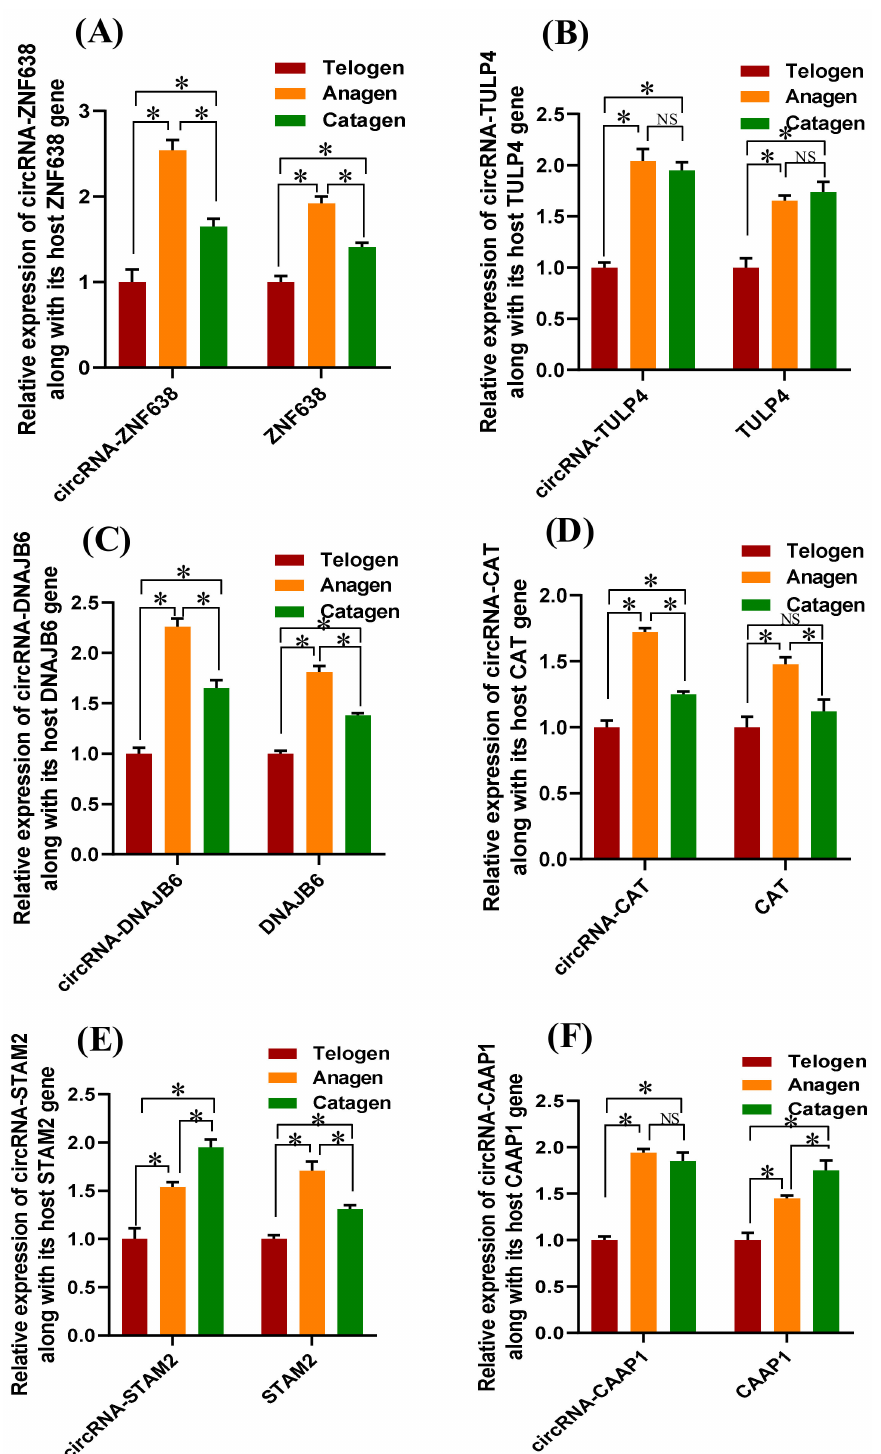
Figure 7. Expression analyses of the six anagen up-regulated m 6 A-circRNAs along with their host genes in SHFs of cashmere goats at telogen, anagen, and catagen stages. ( A ): circRNA-ZNF638 and its host gene ZNF638, ( B ): circRNA-TULP4 and its host gene TULP4, ( C ): circRNA-DNAJB6 and its host gene DNAJB6, ( D ): circRNA-CAT and its host gene CAT, ( E ): circRNA-STAM2 and its host gene STAM2, and ( F ): circRNA-CAAP1 and its host gene CAAP1. The expression difference was compared for each m 6 A-circRNA and corresponding host gene at telogen, anagen, and catagen, where the telogen expression data of both m 6 A-circRNA and the corresponding host gene was normalized to